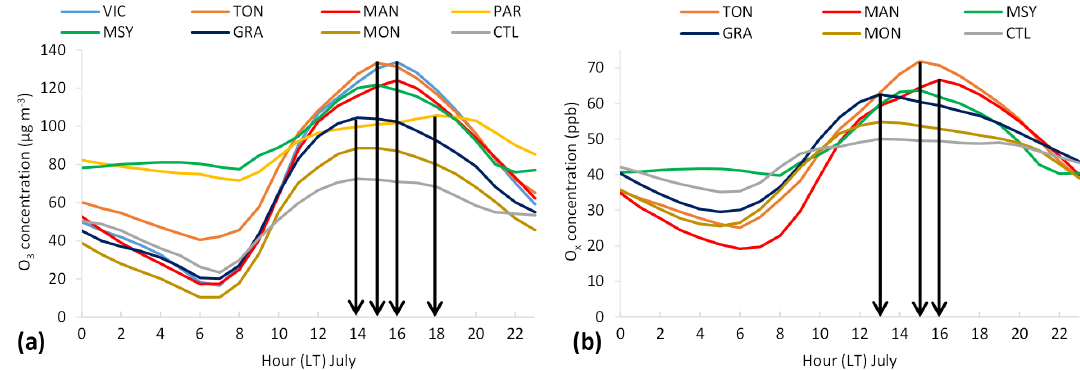
Figure 9. (a) July O 3 and (b) O x daily cycles plotted from mean hourly concentrations measured in air quality monitoring sites located along the S–N axis during 2005–2017. The black arrows point to the O 3 and O x maxima time of the day. Data from Ciutadella (CTL), Montcada (MON), Granollers (GRA), Montseny (MSY), Tona (TON), Vic (VIC), Manlleu (MAN) and Pardines (PAR) air quality monitoring